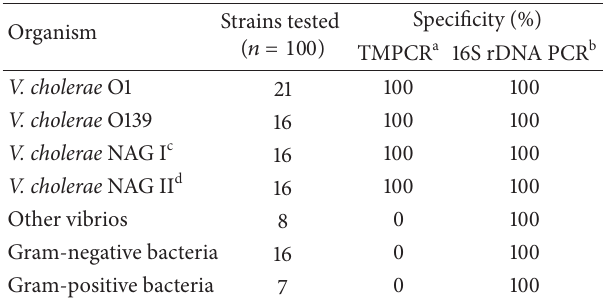
Figure 1: Agarose gel electrophoresis analysis of the PCR algorithm upon annealing temperatures and primer set concentrations that had effects on yields of three specific amplicons. In a 25 𝜇 L PCR assay using 10ng each of purified V. cholerae O1 and O139 gDNAs, amplification was performed in triplicate with varying concentra- tion of three primer sets ( 𝜇 M) (a to h) and annealing temperature increments ( ∘ C) at 54.2, 55.5, and 56.9. The 100 bp molecular marker (lane M) and serogroup-specific PCR amplicons as positive control (lane PC) were used for base pair size comparisons. Table4:AmplificationspecificityofTMPCRand16SrDNA-specific